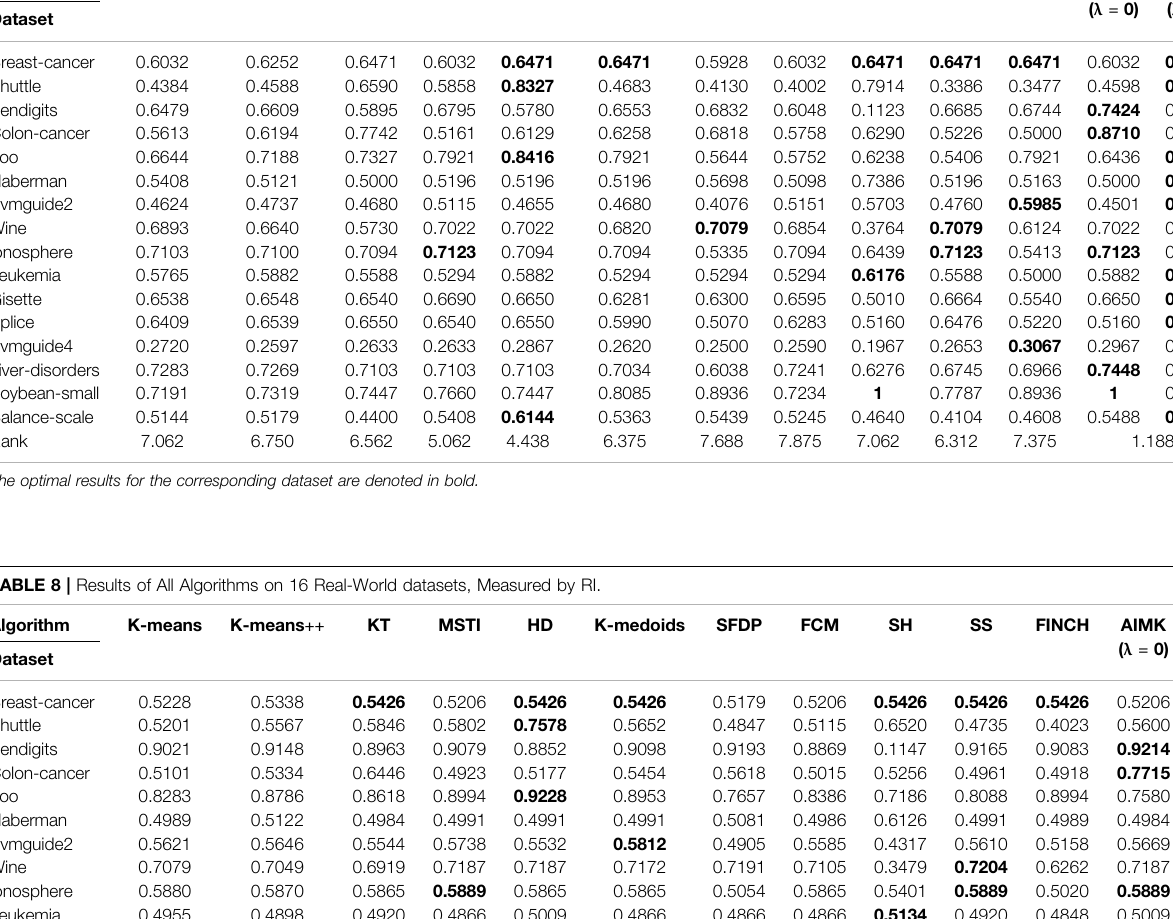
TABLE 7 | Results of All Algorithms on 16 Real-World datasets, Measured by ACC. Algorithm